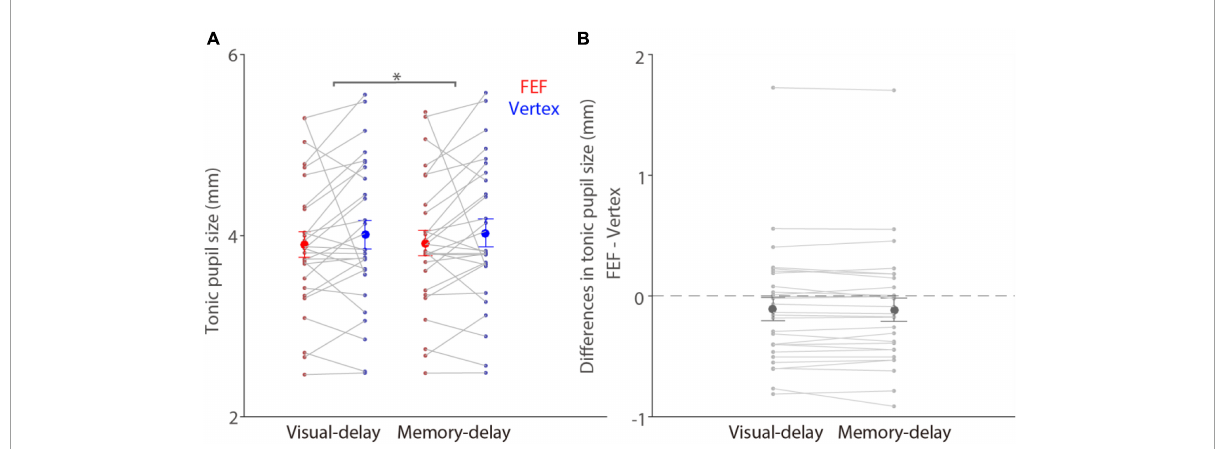
FIGURE3 No modulation of FEF cTBS on tonic pupil size. (A) Modulation of stimulation on tonic absolute pupil size before the patch presentation (100–200 ms before patch onset) in the visual- and memory-delay tasks ( N = 28). (B) Differences in tonic pupil size between the FEF and vertex stimulation conditions (FEF minus vertex). The large circles and error-bars represent the mean values ± standard error across participants. The dots represent mean value for each participant. *Indicates differences are statistically significant ( p < 0.05).